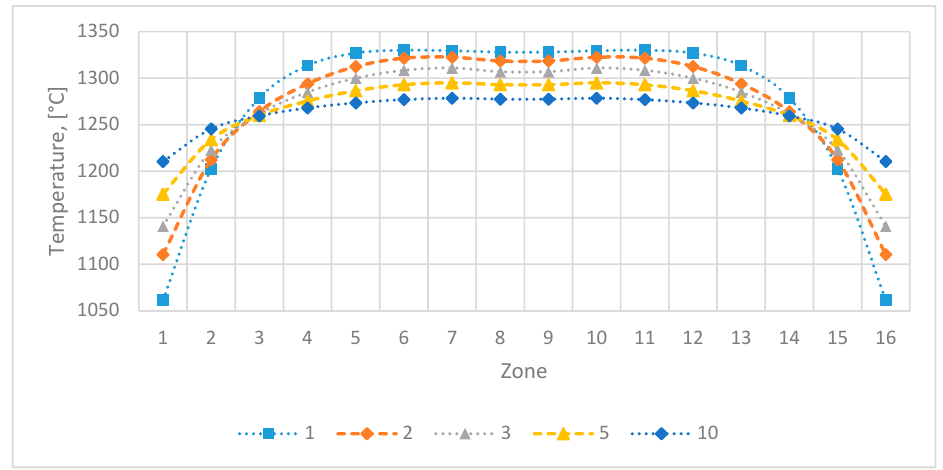
Figure 10. The temperature distribution in the zones of the furnace at M Total = max ( q total = max) with a variable rate of recirculation of furnace gases with minimum thermal power.